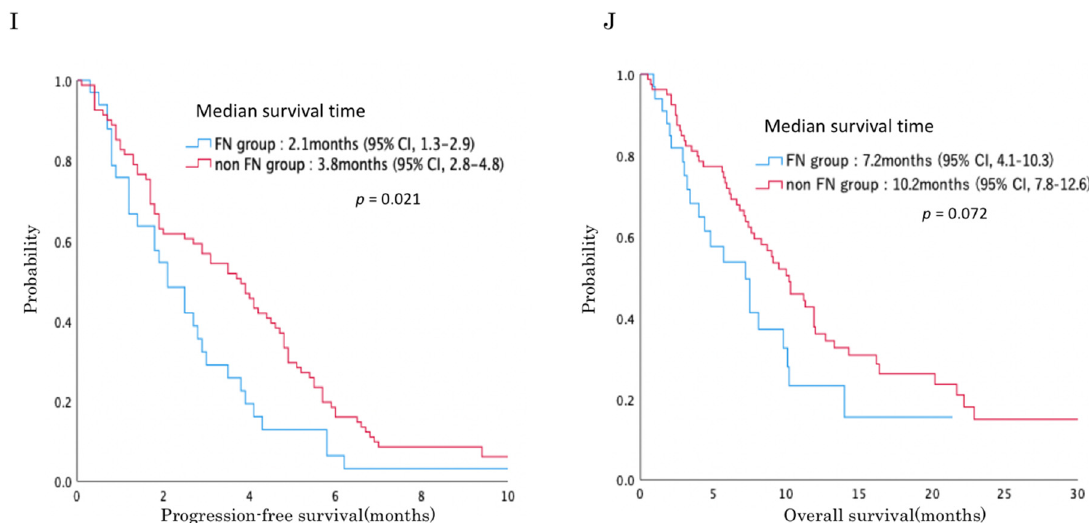
Figure 2. Survival curves using the Kaplan–Meier method for patients treated with amrubicin. ( A ) Progression-free survival curve of all 156 patients. ( B ) Progression-free survival curve of patients with or without FN. ( C ) Progression-free survival curve of patients with or without grade 4 (G4) neutropenia. ( D ) Progression-free survival curve of patients treated with or without G-CSF. ( E ) Overall survival curve of all 156 patients. ( F ) Overall survival curve of patients with or without FN. ( G ) Overall survival curve of patients with or without grade 4 neutropenia. ( H ) Overall survival curve of patients treated with or without G-CSF. ( I ) Progression-free survival (PFS) curve and median survival times of 111 small cell lung cancer patients with or without febrile neutropenia (FN). ( J ) Overall survival (OS) curve of 111 small cell lung cancer patients with or without FN. Table 3. Potential risk factors for OS by the univariate Cox proportional hazards analysis ( N = 156).